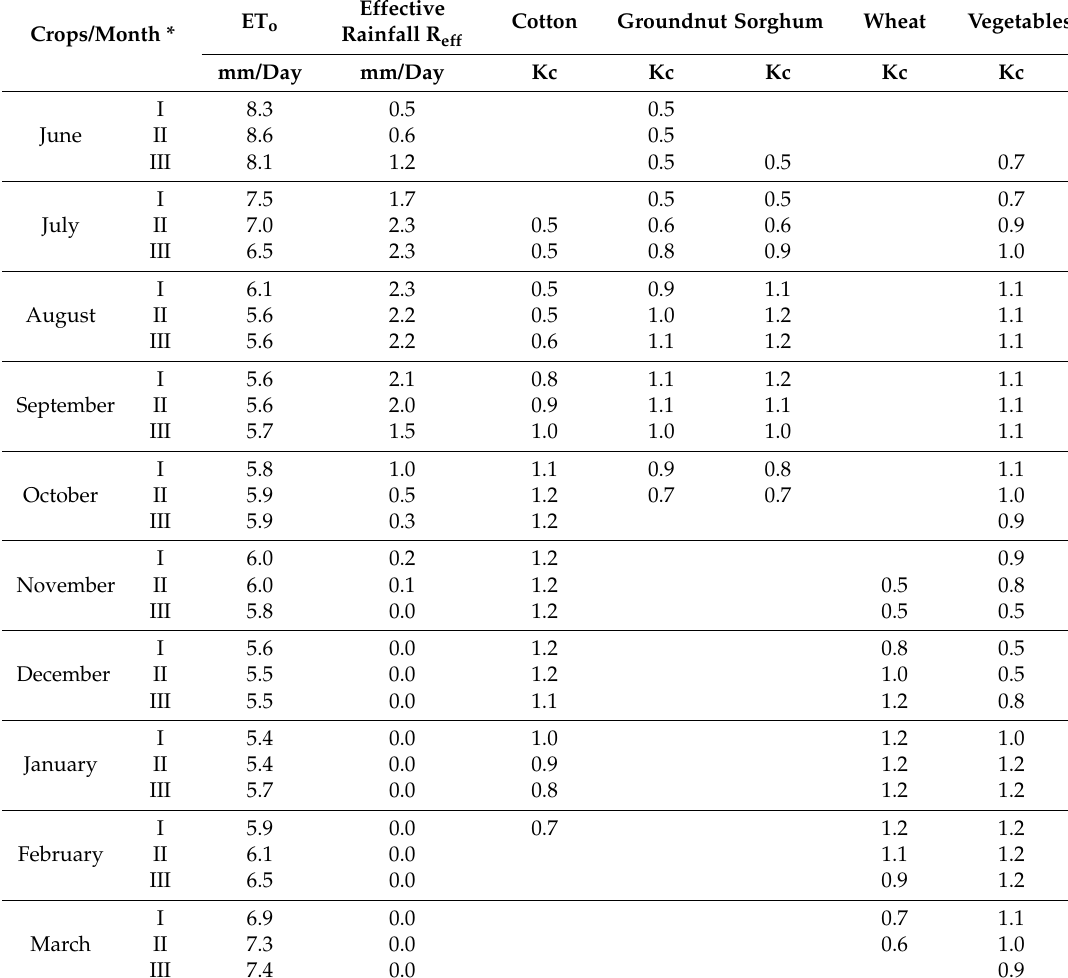
Table 2. Average climatic data and Kc values for Gezira scheme main